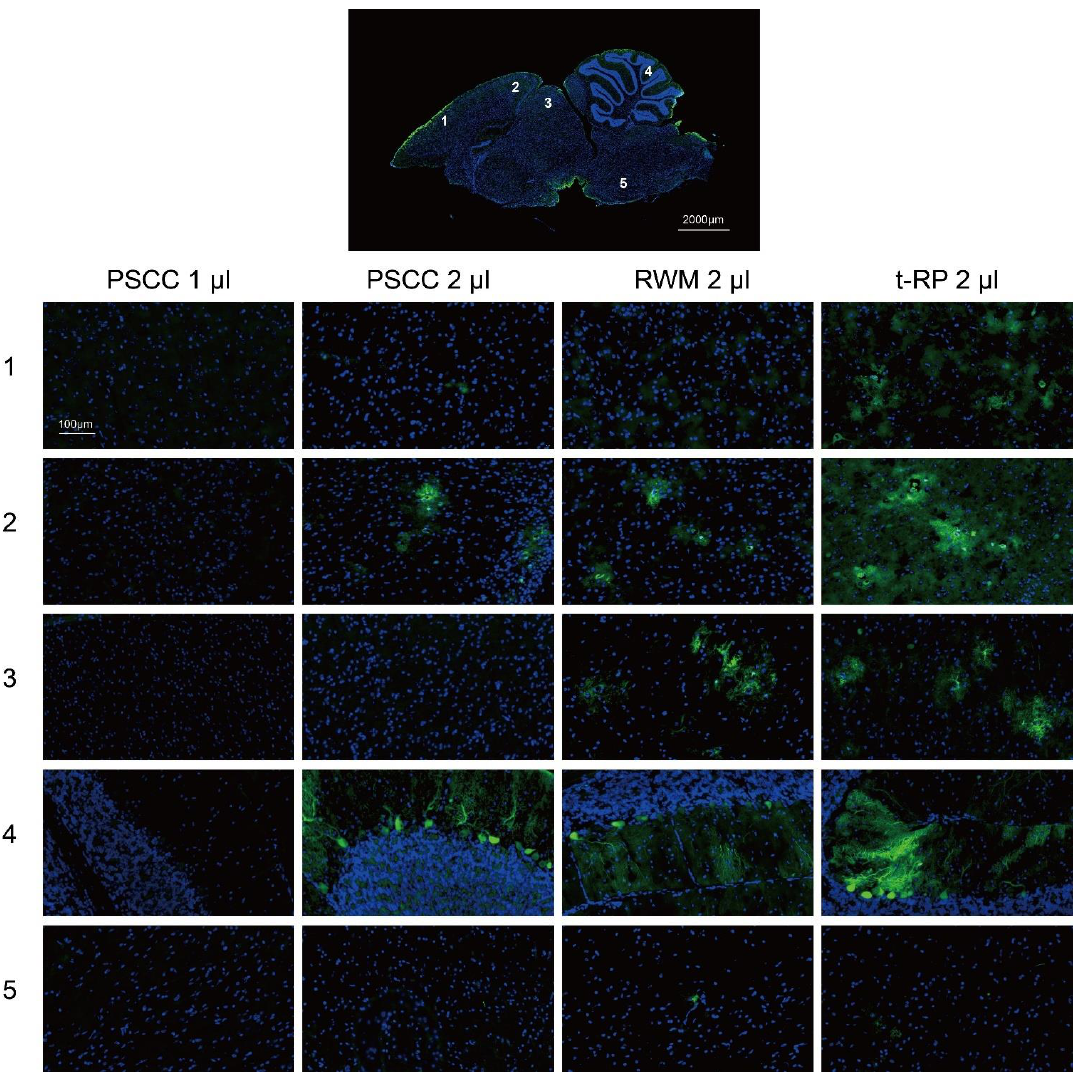
Figure 4. Frozen sagittal brain sections from AAV-Anc80L65-injected adult mice (4–6 weeks old) using different surgical approaches. Two weeks after the cochlear injection, brain tissues were rapidly extracted. The whole sagittal brain section image at the top came from the t-RP group, and the high-magnification images were taken from the following brain regions of each group: the cerebral cortex (1 and 2), midbrain (3), cerebellum (4), and hindbrain (5). The cell nuclei were stained with DAPI (blue), and native eGFP was imaged